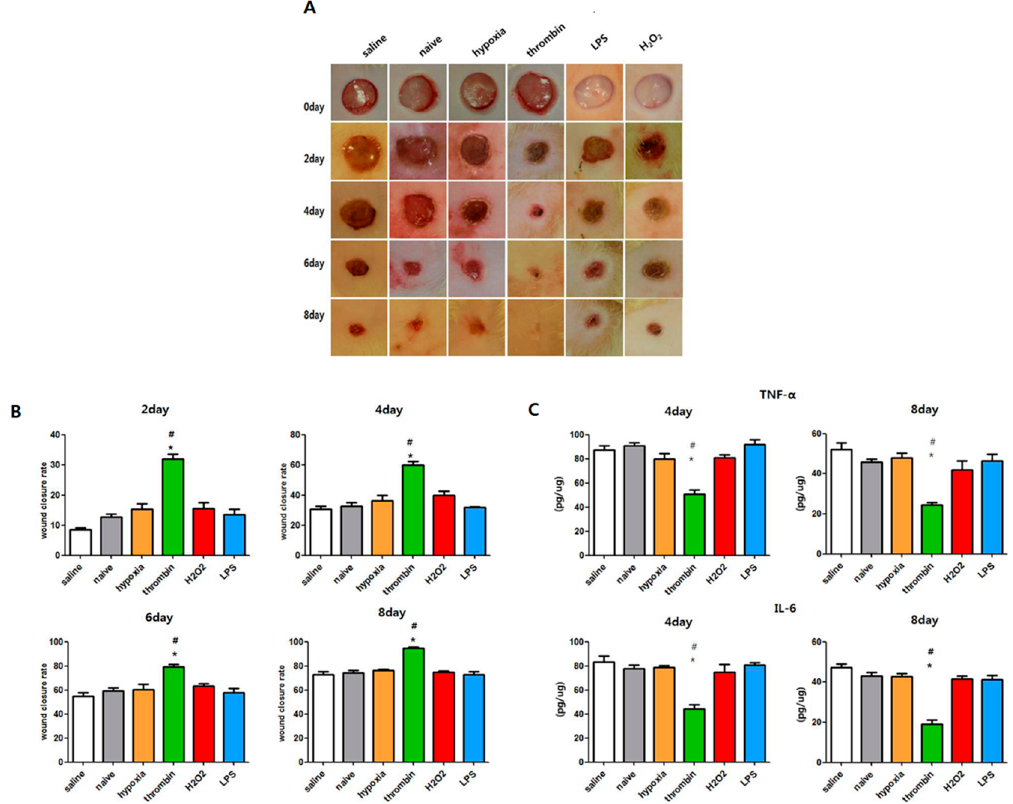
Figure 8. Comparison of wound healing capacity of EVs with the same protein amount (20 µ g) in vivo. Punch wounds of animals were treated locally with saline, naive MSC-DERIVED EVs, 10% O2 EVs, thrombin (40 U) EVs, LPS (1 µ g) EVs, or H2O2 (50 µ M) EVs derived from the same number of MSCs. ( A ) Representative serial wound images in vivo and ( B ) the relative wound closure rate (%) after 2, 4, 6, and 8 days of treatment ( C ) Cytokine analysis for TNF- α and IL-6 β in the homogenate of dissected wound tissues four and eight days after each treatment. Statistical analyses were carried out using a One-way Analysis of Variance (ANOVA). The asterisk (*) indicates p < 0.05 compared with saline, and the number sign (#) indicates p < 0.05 compared with the naive EV group ( n = 4 per each analysis).